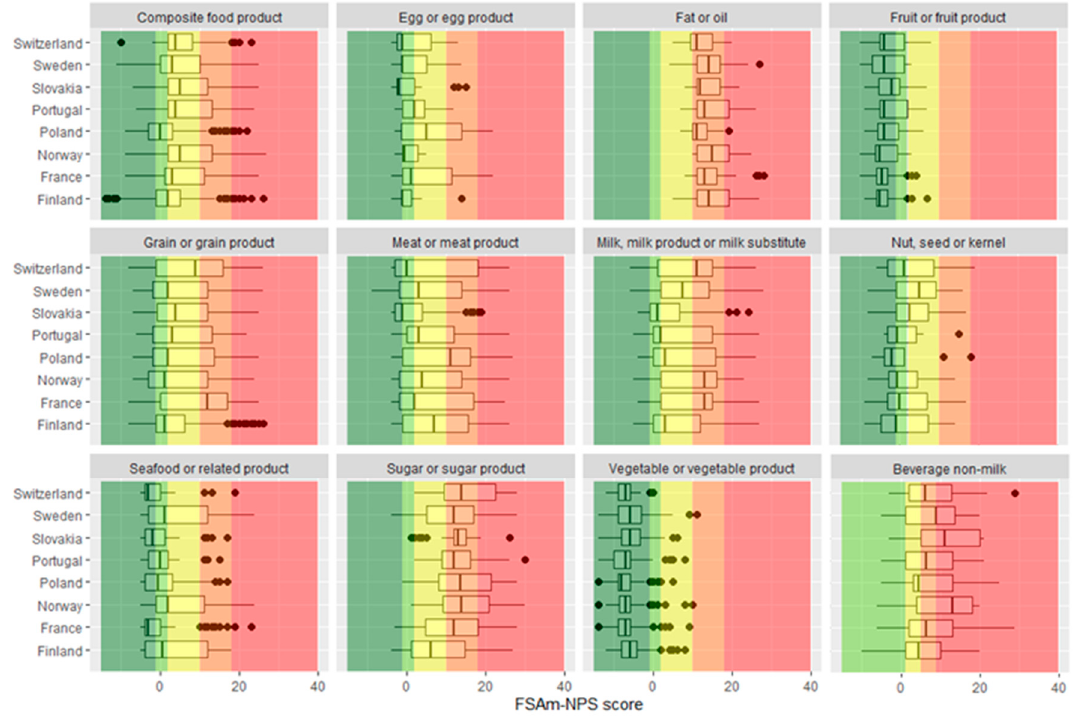
Figure 1. Overall distribution of products within the main food groups and across countries. Dark green: Nutri-Score “A”, light green: Nutri-Score “B”, yellow: Nutri-Score “C”, light orange: Nutri-Score “D”, and dark orange: Nutri-Score “E”. No Nutri-Score “A” was represented on the graphic of beverages, given that only waters can be classified as “A” and were thus excluded from the graphic. Values are the number of food products (%).